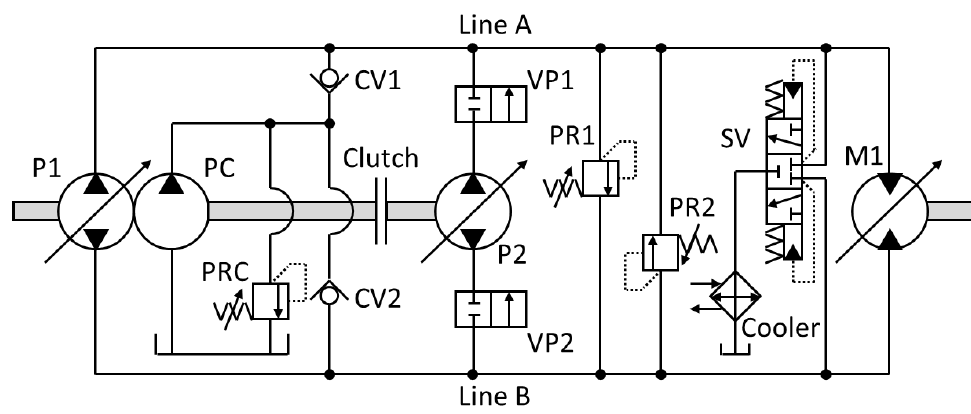
Figure 3. Transmission Schematic for Proposed Solution A.